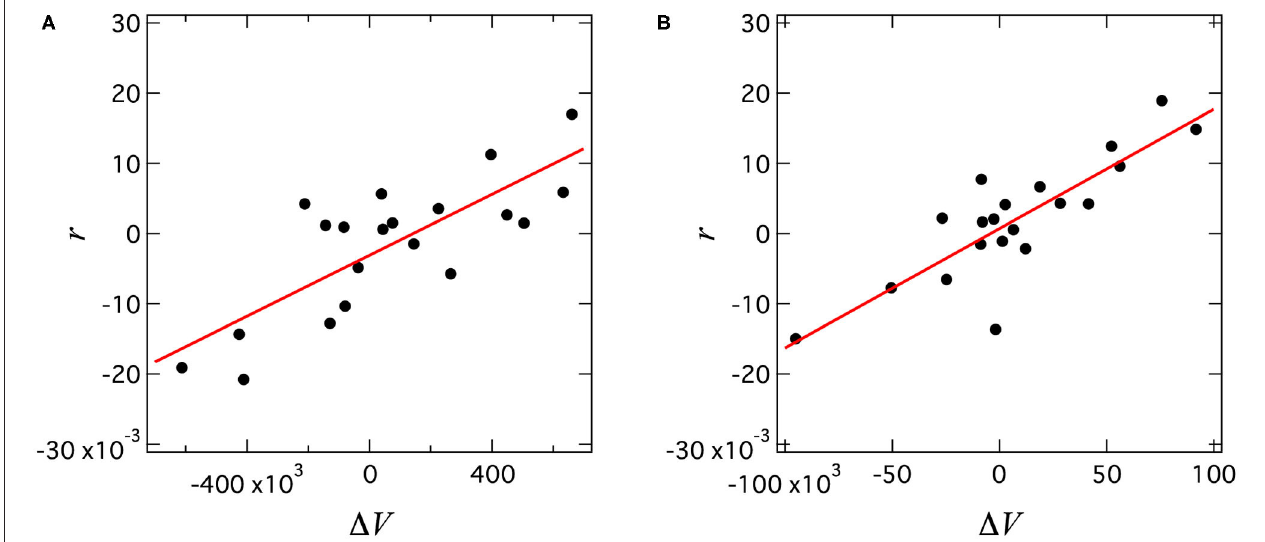
Figure 2 shows a scatter plot of the return ( r ) and the executed order imbalance ( 1 V ) of the Sony Corporation (stock code: 6758) in the Core 30 and Nippon Paper Industries Co.,